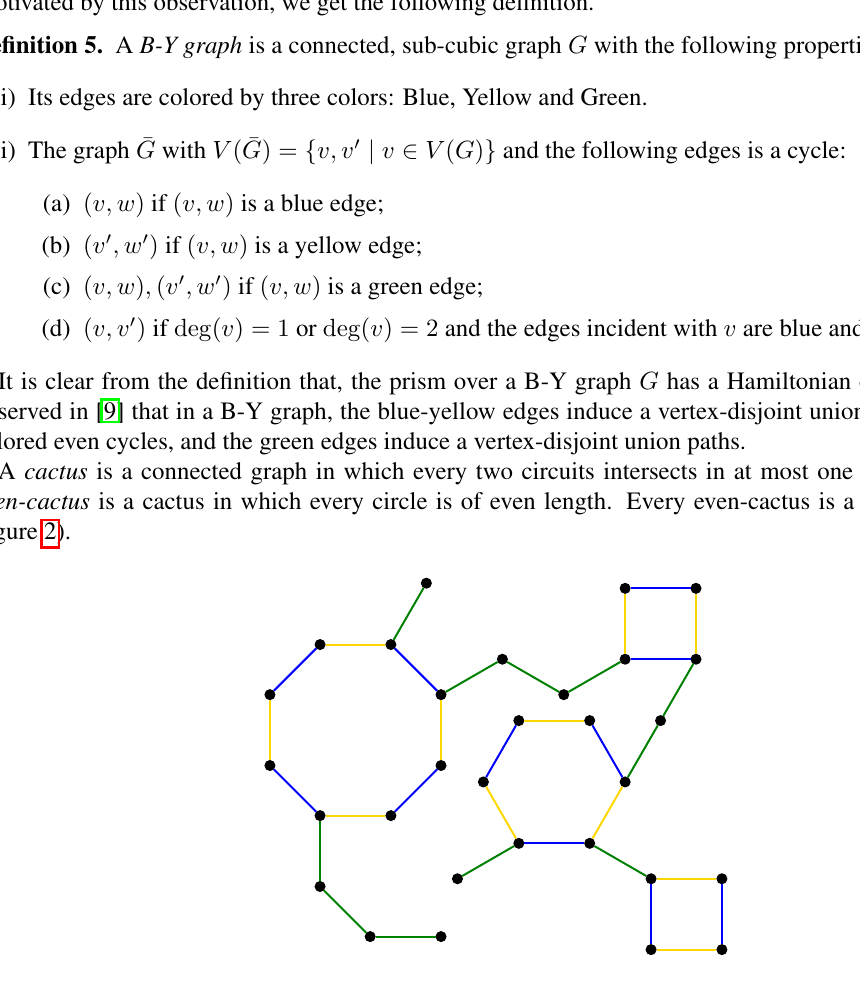
Fig. 2: An even cactus viewed as a B-Y graph. The edges in a circuit are colored B-Y and the edges that are not in any circuits are colored